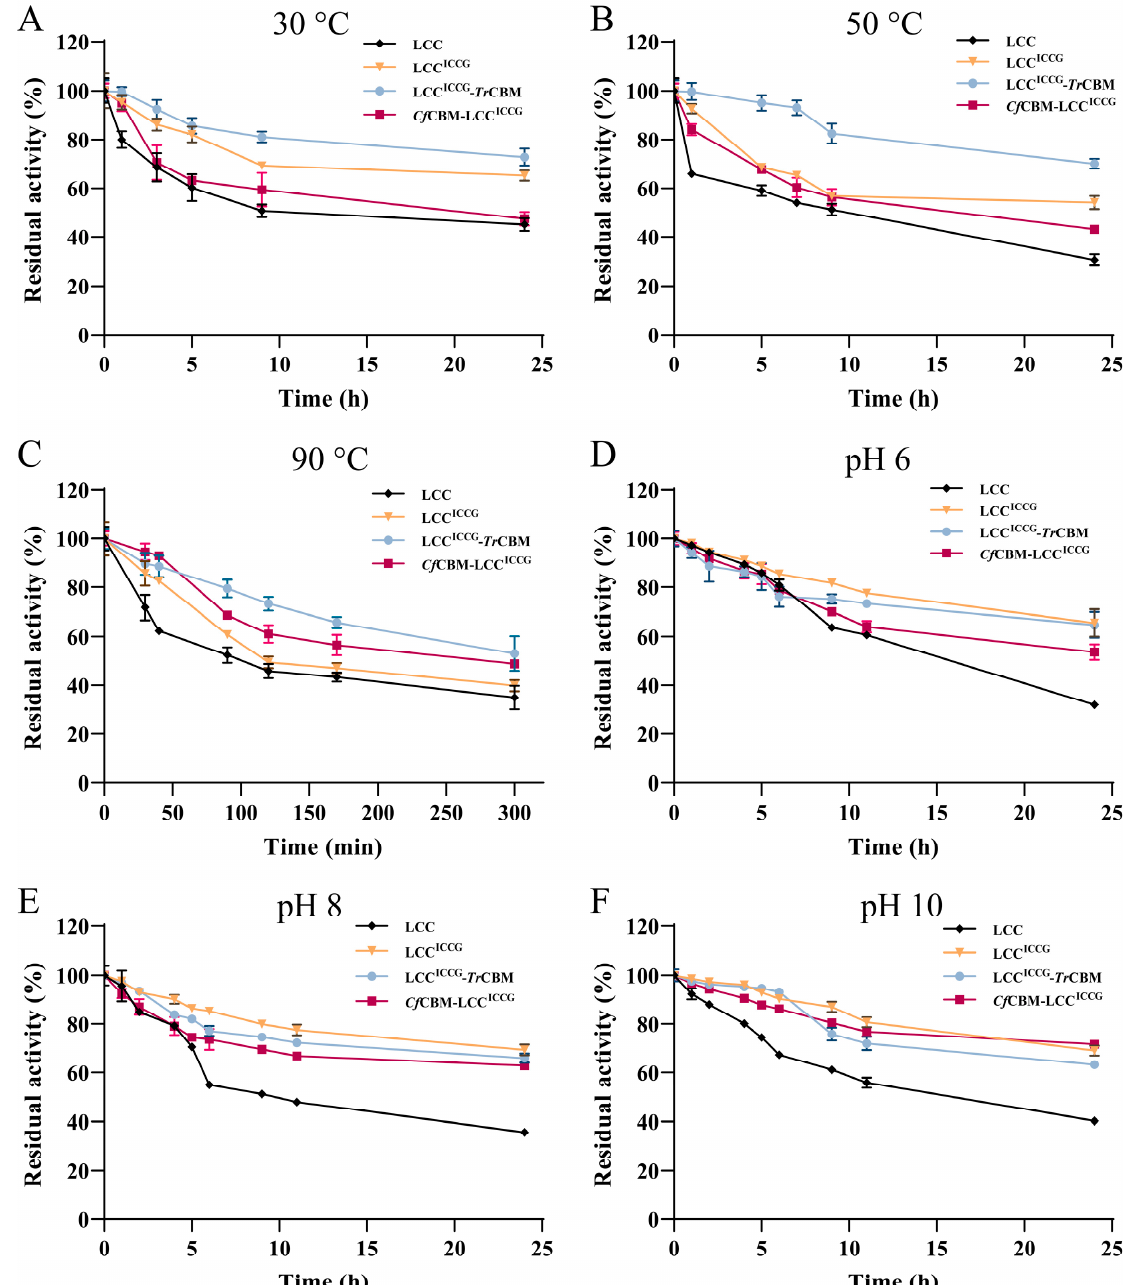
Figure 4. Evaluation of thermal and pH stability using p -NPC as a substrate. Residual activity of LCC, LCC ICCG , LCC ICCG - Tr CBM and Cf CBM-LCC ICCG after the incubation at 30 °C ( A ), 50 °C ( B ), and 90 °C ( C ) for different times in potassium phosphate buffer (100 mM, pH 8). The residual activity of LCC, LCC ICCG , LCC ICCG - Tr CBM and Cf CBM-LCC ICCG after the incubation in Tris-HCl buffer (20 mM) with different pHs of 6 ( D ), pH 8 ( E ) and pH 10 ( F ) at 30 °C for different times, and the activity was monitored in Tris-HCl buffer solution (20 mM, pH 8.0). Data were presented as mean value ± SD of triplicate experiments.